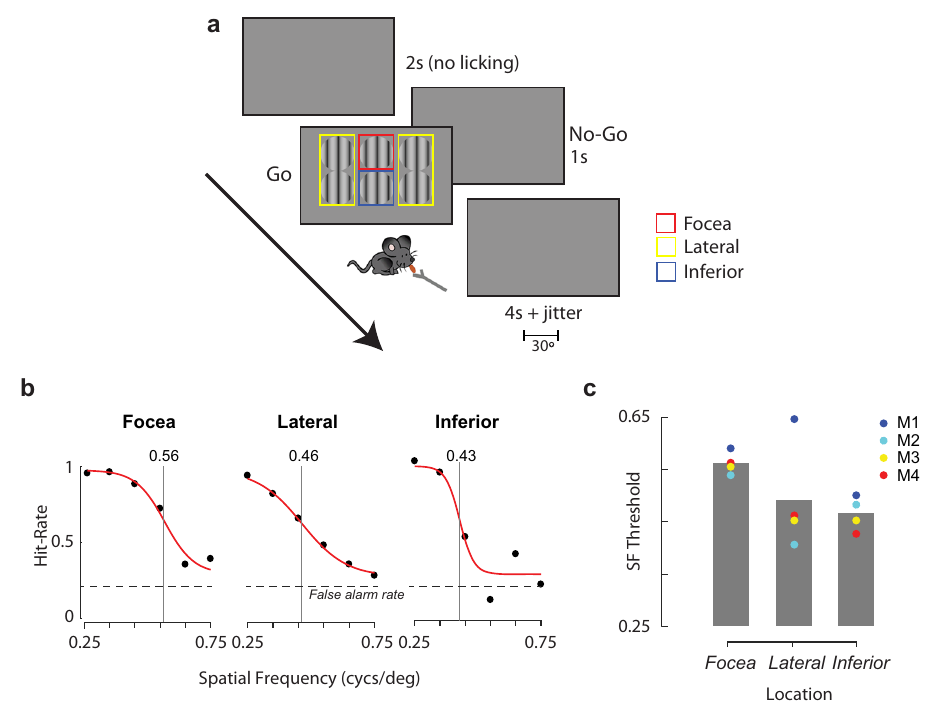
Fig. 7 Visual acuity is higher at the focea. a Contrast detection task. Mice were trained to lick upon detection of a grating stimulus presented at one of 6 different spatial locations ( “ go ” trials). The locations were grouped into three conditions indicated by the colored squares (not visible to the mouse): focea (red), lateral (yellow), and inferior (blue). On no-go trials no stimulus was presented and mice were trained to refrain from licking. False alarms were punished with timeouts. b Fraction of correct “ go ” trials for different spatial frequencies of the grating for three different spatial locations for an example mouse. “ Focea ” indicates stimuli presented in the upper-central visual fi eld at (0° azimuth, 20° elevation), “ Lateral ” shows responses pooled over the four stimuli at lateral locations (±35° azimuth, − 10°/ + 20° elevation), and “ Inferior ” for stimuli presented in the lower-central visual fi eld at (0° azimuth, − 10° elevation). The vertical line indicates the spatial frequency threshold, estimated by fi tting a logistic function. c Spatial frequency thresholds for four mice at the three locations (data from the four lateral locations were similar and is pooled). Spatial frequency thresholds were signi fi cantly higher for the focea